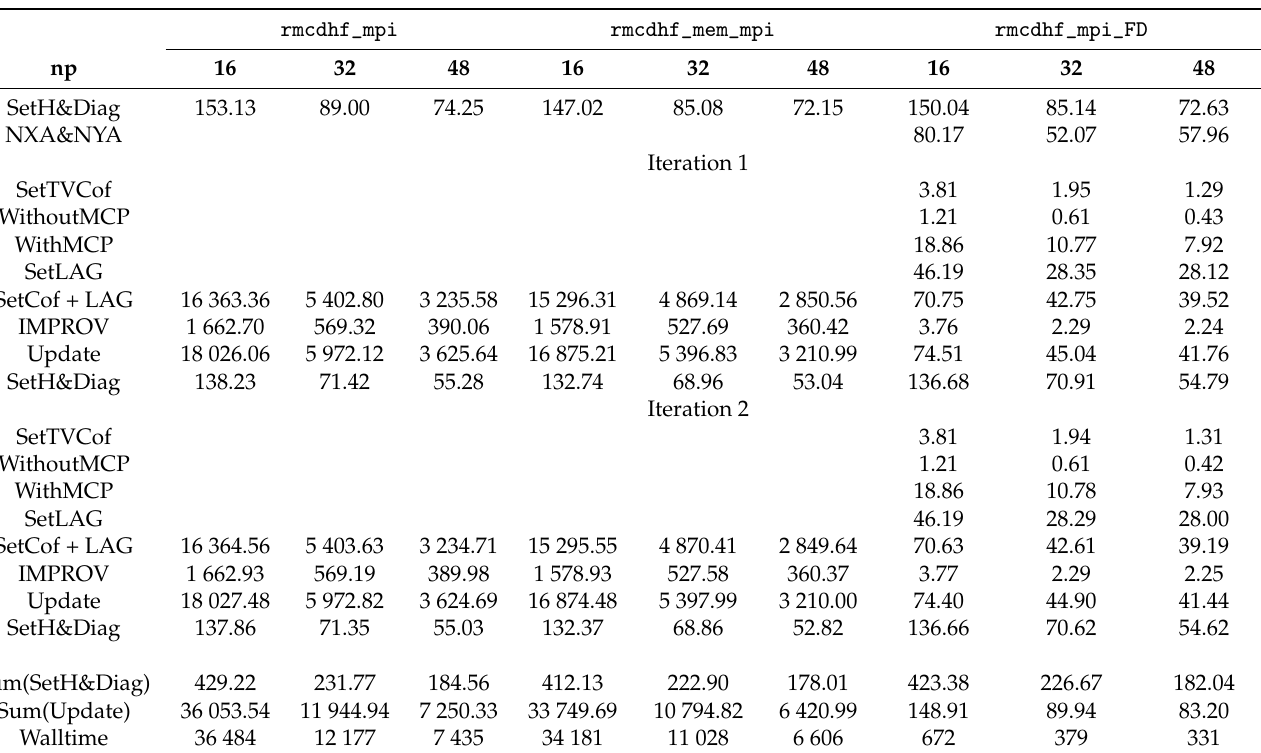
Table 5. CPU times (in s) for the Be I n = 15 SCF calculations using the rmcdhf_mpi , rmcdhf_mem_mpi and rmcdhf_mpi_FD codes as a function of the number of MPI processes ( np ). See text for the label